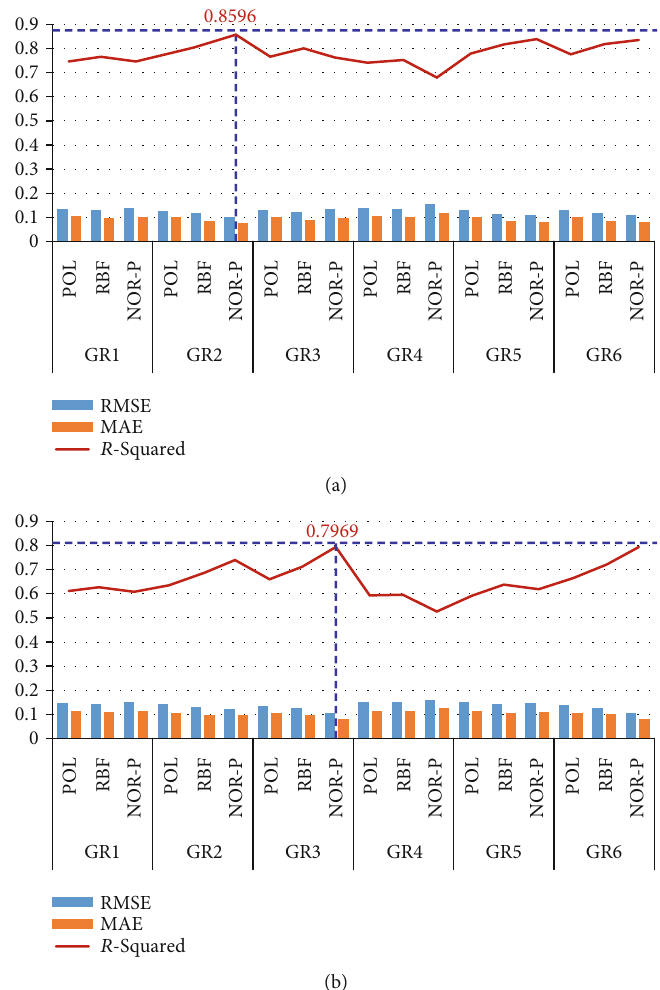
Figure 11: Estimation performance of the models developed with SVR by using 3 kernel functions for (a) Kahramanmaras and (b)